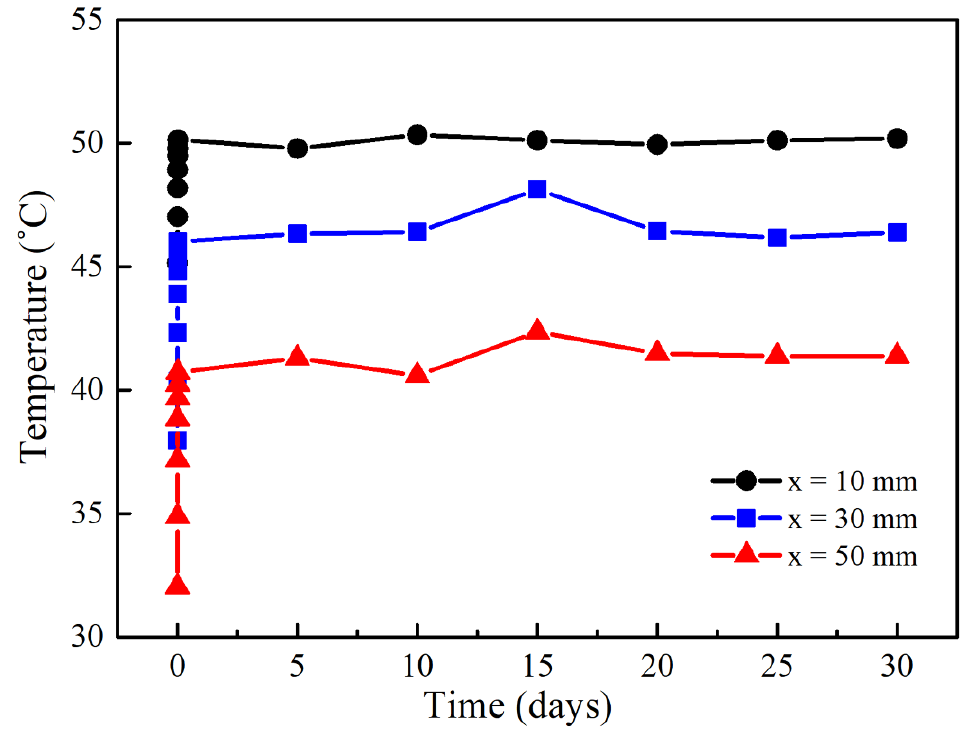
Figure 5. Internal temperature measured at depths of 10, 30, and 50 mm in temperature gradient condition vs. exposure time. (Single-column fit).